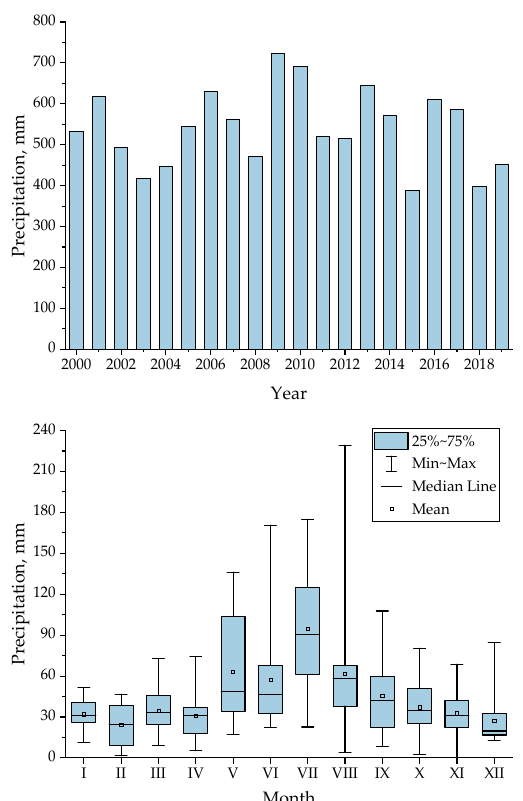
Figure 1. Annual and average monthly rainfall amounts in Wrocław in the years 2000–2019. The average annual rainfall in the analyzed period was 541 mm, with the highest annual rainfall of 723.5 mm recorded in 2009, and the lowest amounting to 388.3 mm in 2015. Figure 2 shows that the highest average monthly rainfall occurs in the summer sea- son, from May (V) to October (X), and within a range from 37.1 mm (X) to 94.9 mm (VII). In the colder half-year, from November (September) to April (April), the average monthly rainfall ranges from 24.4 mm (II) to 34.4 mm (III). The preparation of the archive data was necessary as input data for the model used in the simulations. Both dry and most humid months are visible.